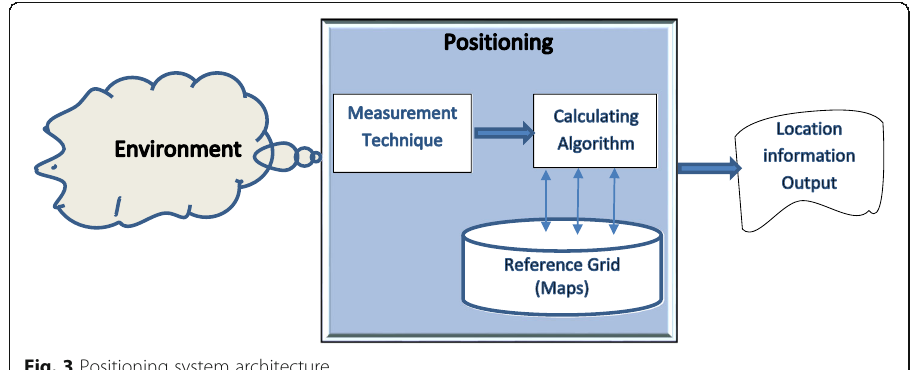
Fig. 3 Positioning system